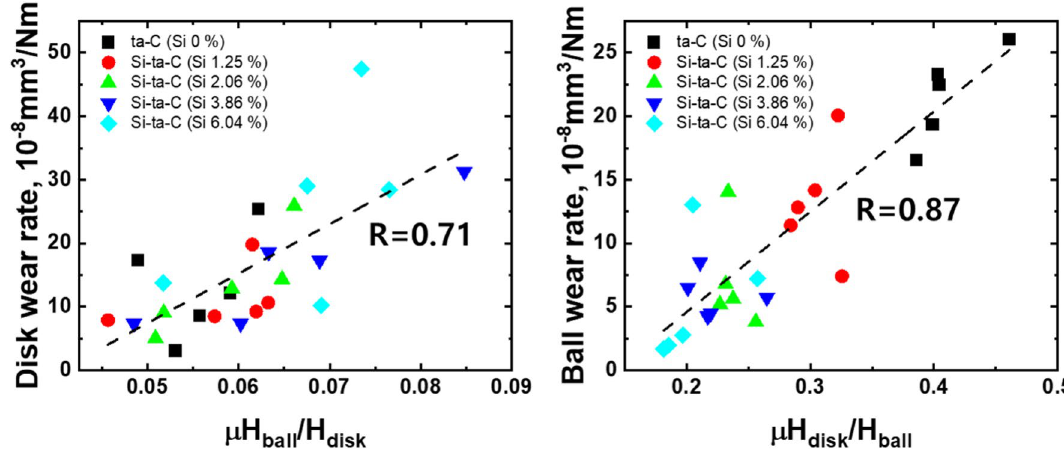
Figure 12. Relationship between abrasive wear index μH disk / H ball (calculated by average CoF and nano- hardness) and disk wear rate and ball wear rate.